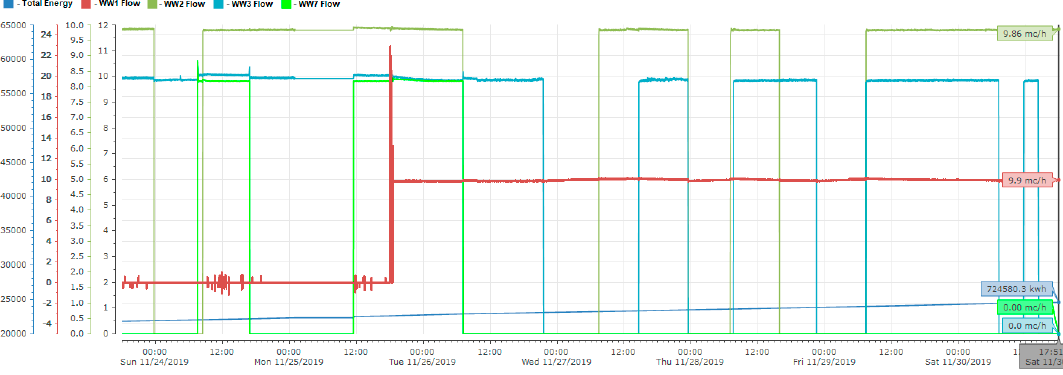
Figure 11. Results with constrained FDC. Well flows (mc/h) and energy consumption (kWh) in Week 1 of tests.